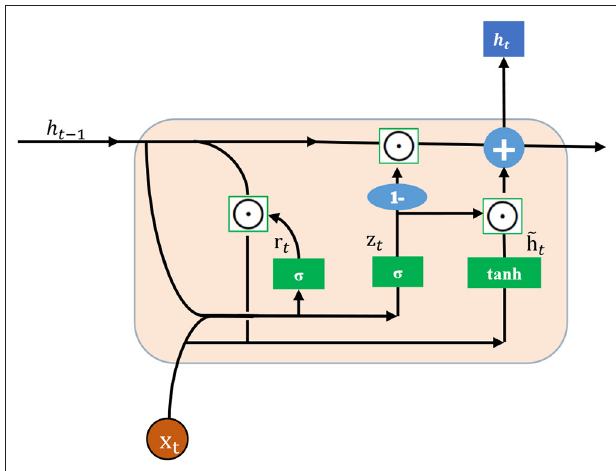
FIGURE 2 | Illustration of the convolutional gated recurrent unit